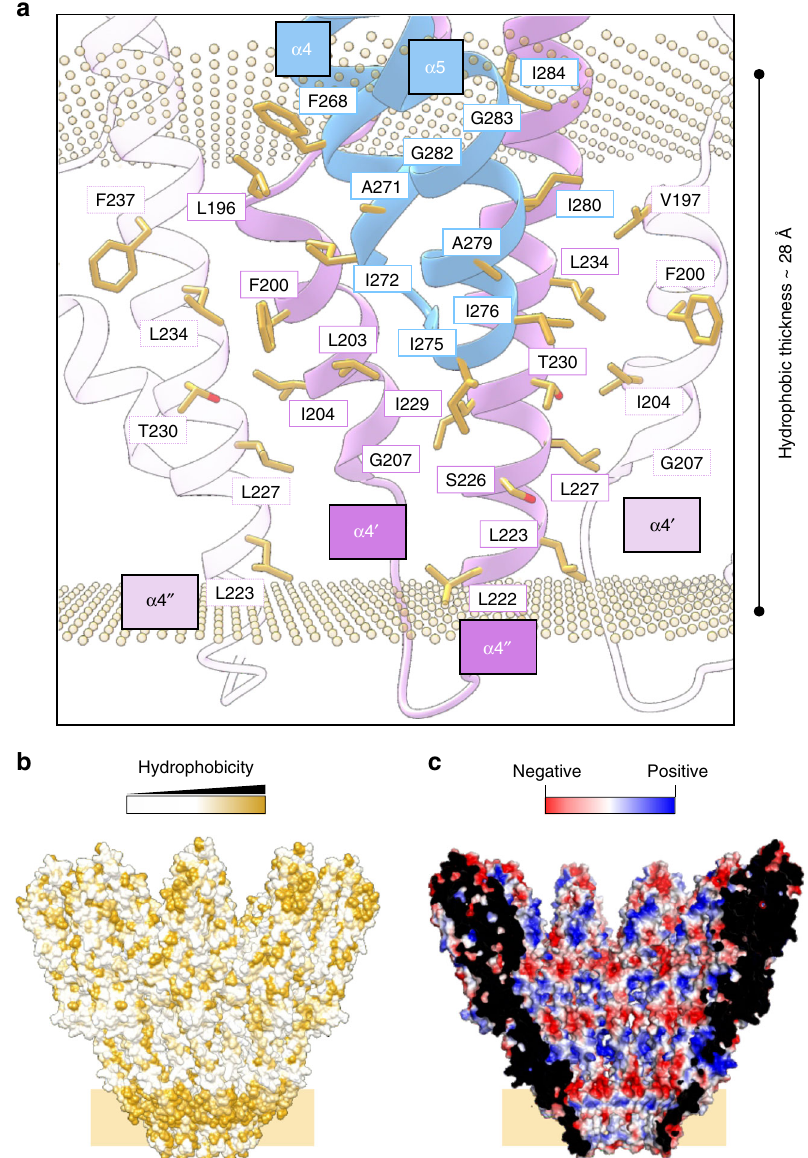
Fig. 4 The transmembrane pore is composed of YaxA and YaxB foot domains. a Details of a transmembrane segment of the pore. The YaxAB pore model (YaxA: blue, YaxB: pink) was submitted to the PPM server to delineate the buried hydrophobic membrane surface. Shown are foot domains from one cis -dimer, as well as the neighboring protomers (transparent ribbons). Membrane exposed residues are colored in gold. The golden spheres demarcate the calculated boundaries of the apolar surface. b Hydrophobic surface rendering of the YaxAB model. Gold coloring indicates high hydrophobicity. The golden rectangle delineates the approximate membrane boundaries. c Charge distribution of the pore lumen. The surface is rendered by the qualitative electrostatic representation implemented in PyMOL (Schrödinger,